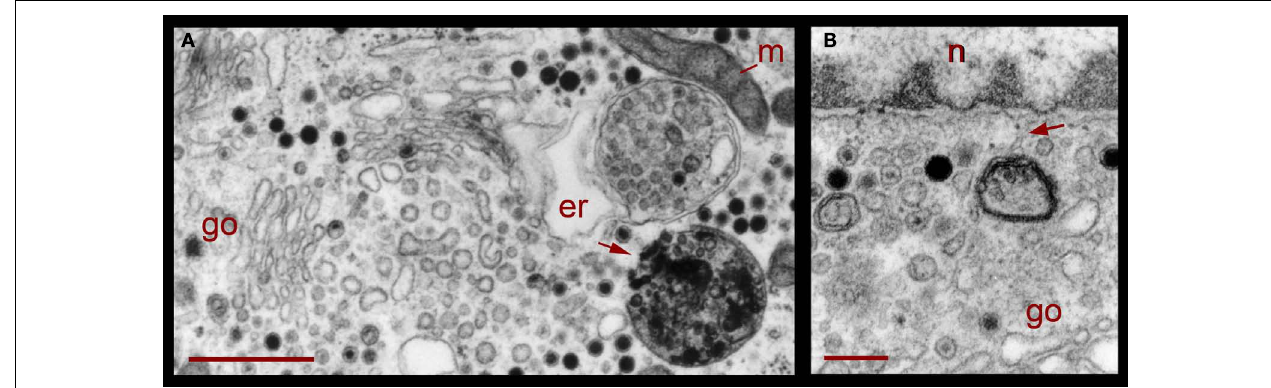
vesicles near the Golgi endings (asterisks) display electrodense material inside. (B) Contents of the multivesicular bodies are in association with the nuclear membrane and near Golgi apparatus (n = nucleus).The arrowhead points to structures possibly binding the multivesicular body fragment with the nuclear membrane. Scale bars =